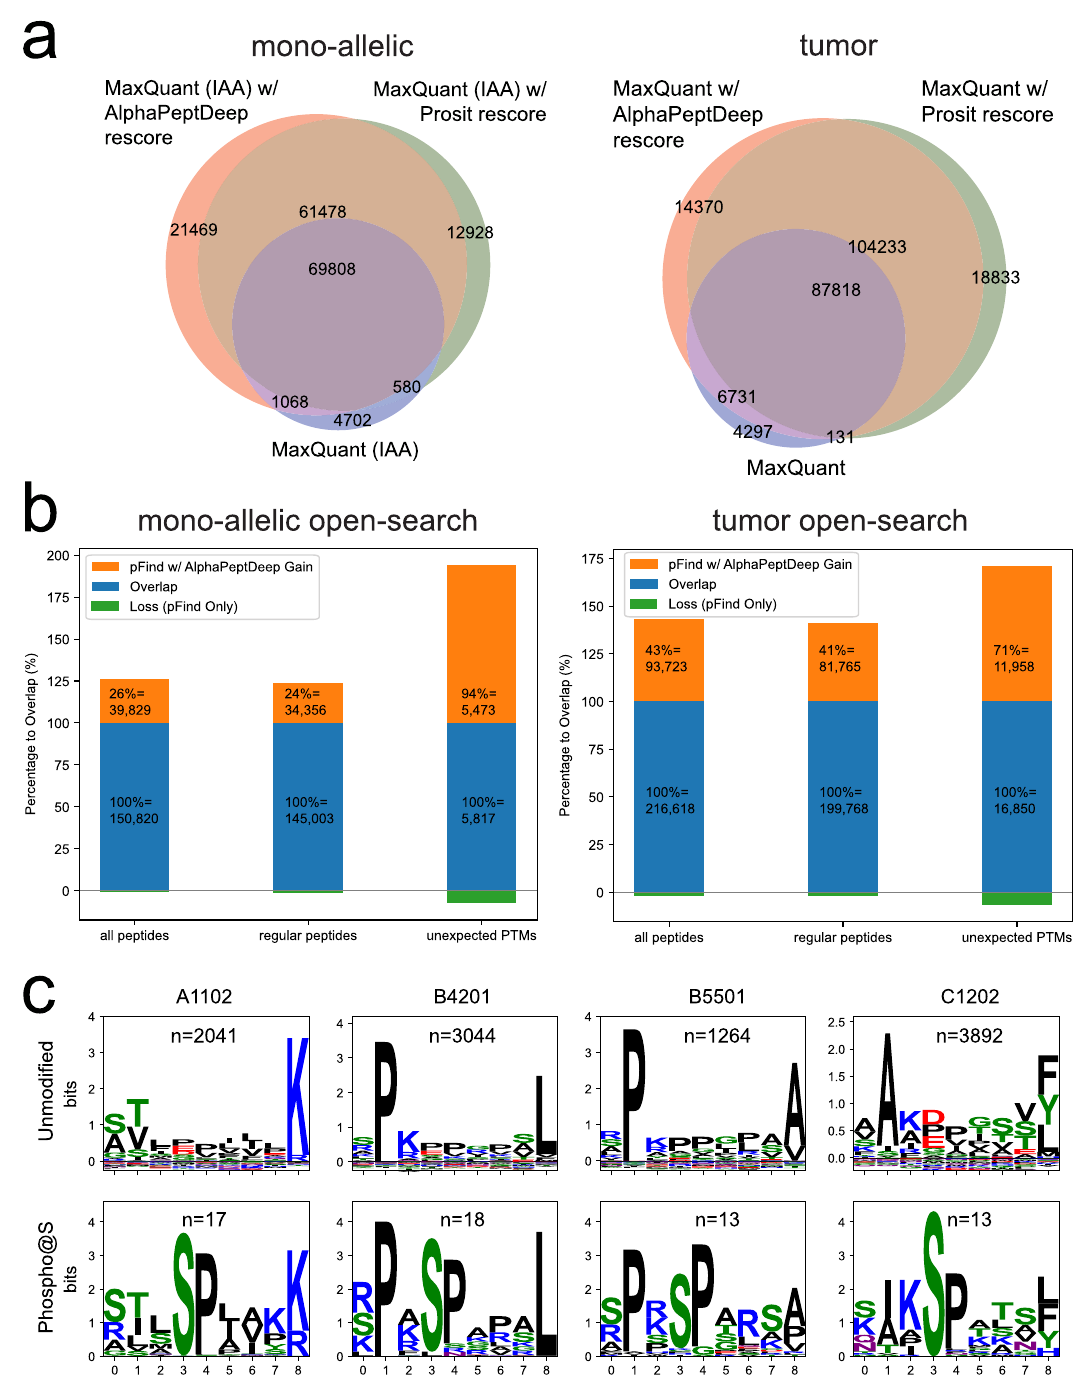
Fig. 5 | AlphaPeptDeep drastically improves results for DDA identi fi cation of HLA peptides. a Improvement upon regular search (MaxQuant). IAA refers iodoacetamide alkylated peptides. b Improvement upon open-search (pFind). Regular peptides here refer to peptides without modi fi cations or those with only